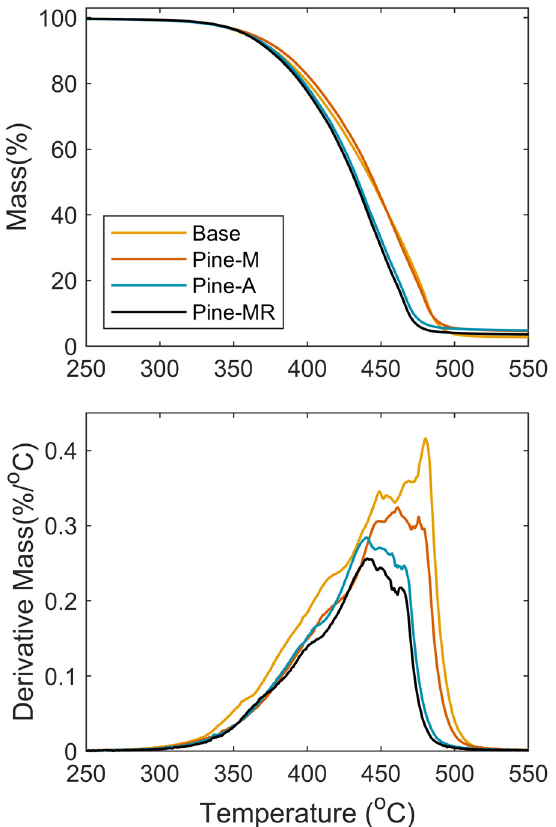
Figure 6. TGA ( top ) and derivative thermogravimetric ( bottom ) curves for base and lignin cured